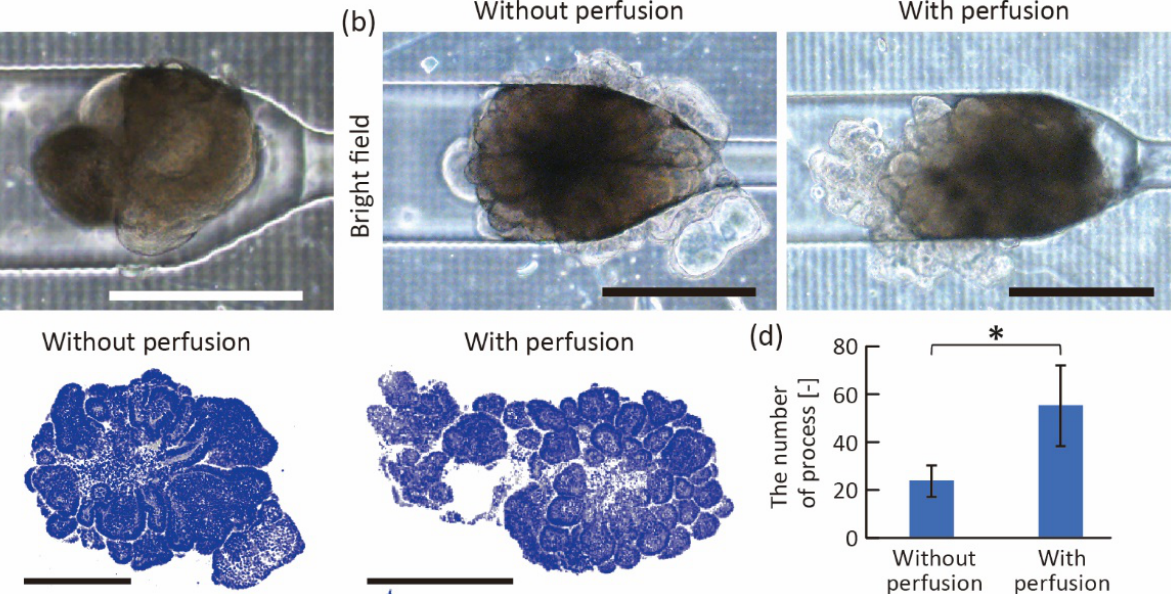
Figure 7. Perfusion culture of trapped organoids. ( a ) Image of trapped organoid before perfusion. ( b ) Bright-field and ( c ) fluorescent images of the organoids after 70 h culture in the device with and without perfusion. White shows actin and blue shows cell nuclei. ( d ) Comparison of the number of buddings in the intestinal organoids with and without the perfusion culture ( n = 4, mean ± s.d., Students’ t -test, p < 0.05). Scale bars are 500 µm.